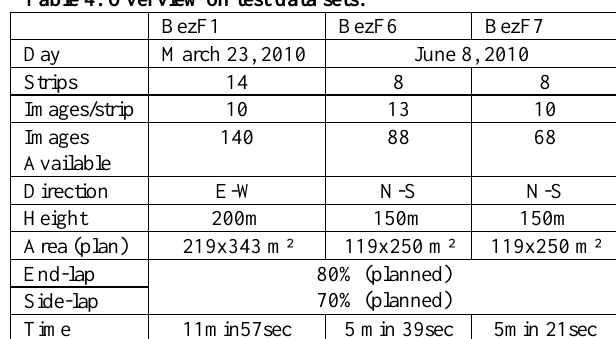
Table 4: Overview on test data